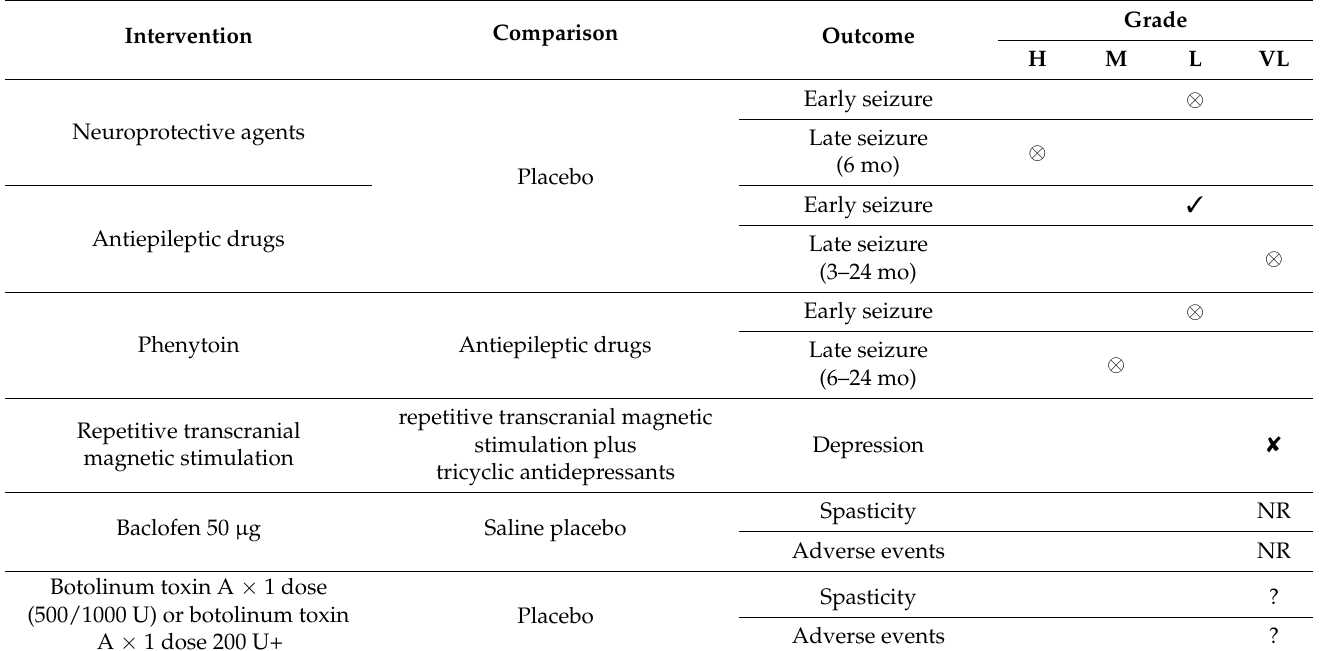
Table 4. Evidence map of pharmacological